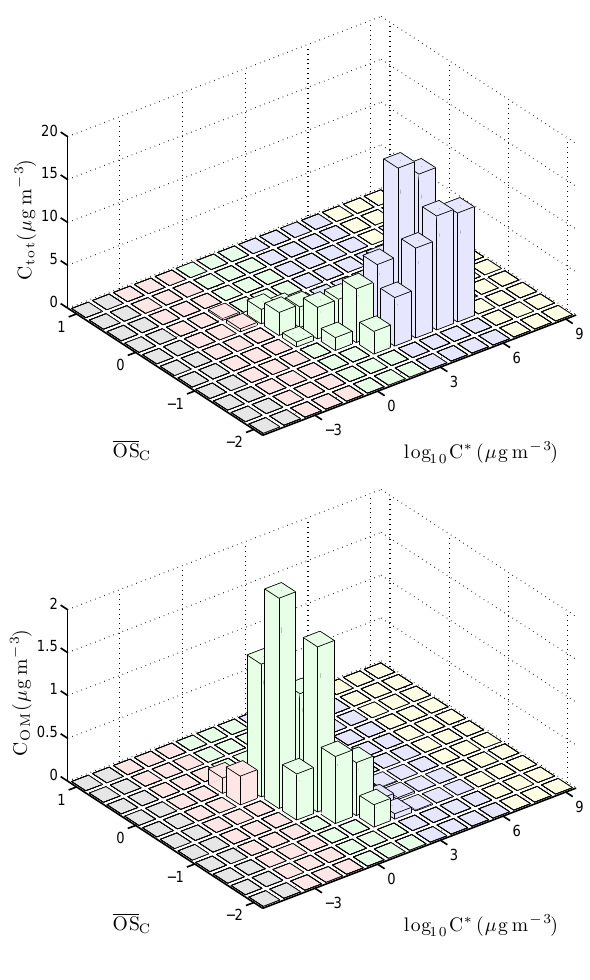
Fig. 4. Two-dimensional VBS histograms of α -pinene+O 3 prod- ucts, showing total organics (top panel) and condensed-phase or- ganics (bottom panel). The lower panel z-axis scale is a factor of 10 finer than the upper panel. Note that most SOA products are SVOCs (green) while most total products are IVOCs